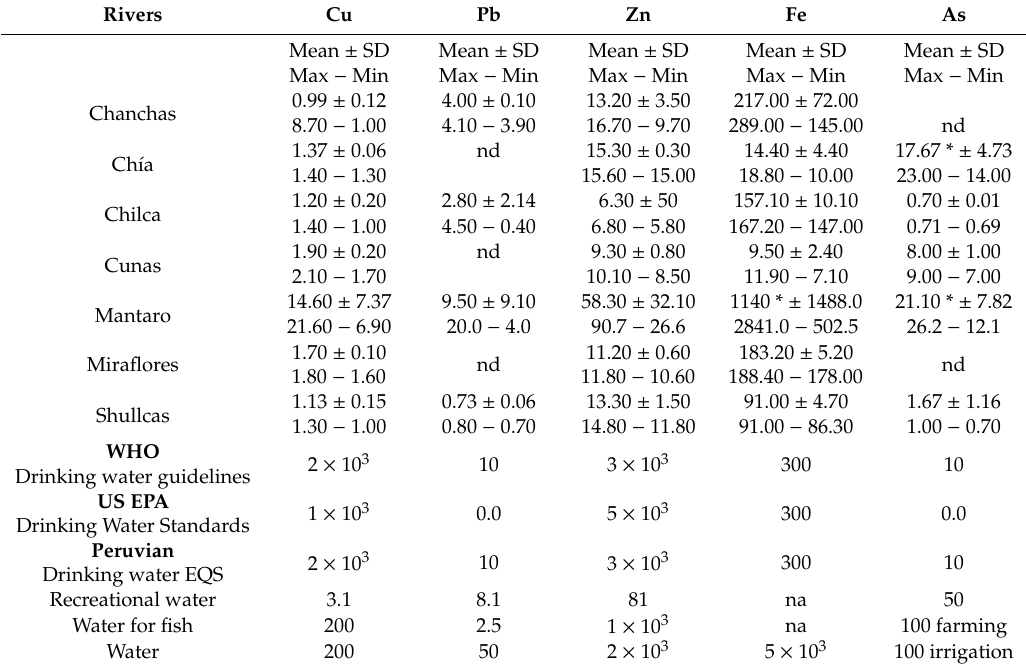
Table 1. Heavy metal and arsenic concentrations in river waters in the Central Andes of Peru and limit values for various uses, expressed in µ g /